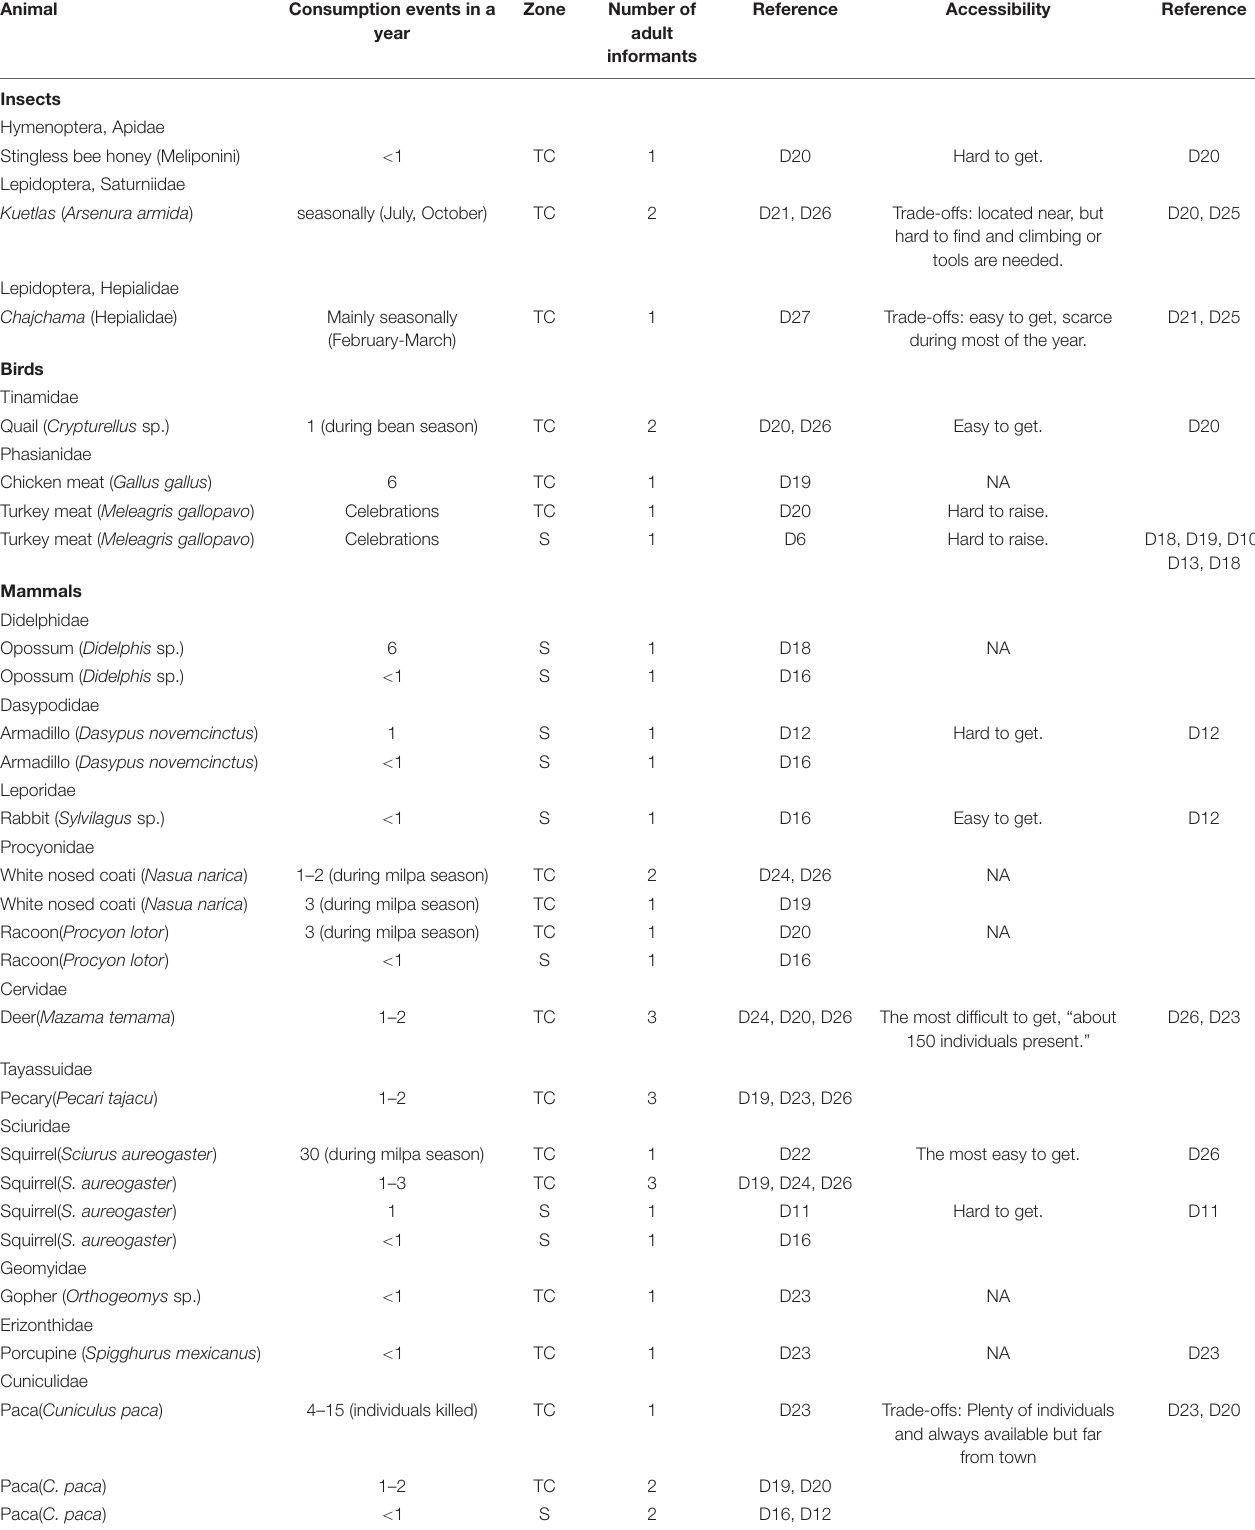
TABLE 7 | Consumption events and accessibility reported for edible animals in adult interviews. Animal Consumption events in a